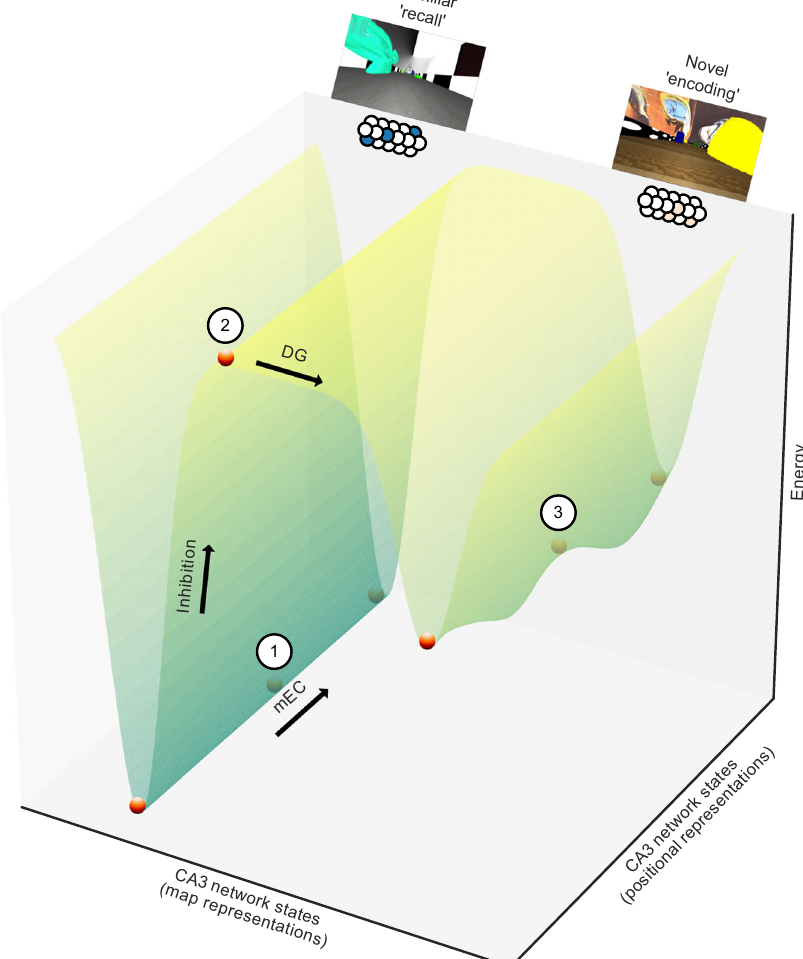
Fig. 6 Switching between familiar and novel attractor states: proposed model. Energy landscape of CA3 network states representing different maps and different positions along the track (schematic). In a familiar environment, the CA3 network falls into an attractor state that is governed by strengthened recurrent synaptic connectivity, thereby performing generalisation during memory recall of familiar events. We propose that a small bias in the inputs from the dentate gyrus (DG) fi rst recruits feed-forward inhibition, thereby lifting the network state out of the deep trough representing the familiar environment. Direct excitation from the dentate gyrus then pushes the CA3 network into a different attractor state with initially weaker, pre-existing recurrent connectivity, thereby performing discrimination during novelty encoding. Numbers represent network states corresponding to the model snapshots shown in Fig. 5c (1: Fig. 5c, left; 2: Fig. 5c, middle; 3: Fig. 5c, right). mEC, medial entorhinal The dura mater was removed using fi ne forceps and the cortical surface was kept monitored daily. Animals were trained to navigate the virtual corridor in the covered with arti fi cial cerebrospinal fl uid of the following composition (in mmol/ familiar environment (F) and to retrieve an 8% sucrose solution reward (10 μ L) by L): 150 NaCl, 2.5 KCl, 10 HEPES, 2 CaCl 2 , 1 MgCl 2 , with pH adjusted to 7.2. In a stopping for at least 3s in an un-cued reward zone placed at a fi xed location of the corridor. Licking behaviour was monitored using a custom-made Arduino piezo- subset of animals, 600 nL of 1mmol/L atropine solution was injected with a large- electric sensor coupled to the reward delivery spout. Animals were ‘ teleported ’ back tip glass micropipette at a depth of 1.7 mm from the cortical surface to selectively to the beginning of the track upon crossing of a de fi ned threshold near the end of target the dentate gyrus 83 . The local injection of the drug was made through a the virtual corridor. As the virtual environments, training protocol and reward standard patch-clamp pipette (thus being equivalent to the fi rst patch-clamp contingencies used in this study are different from the ones used in previous pipette penetration in the ‘ control ’ group) and the anaesthetic and surgical pro- work 12 , the hit rate results are not directly comparable. After having completed the cedures performed on the animals in the ‘ control ’ group and in the group in which fi ve-day training protocol in the familiar environment, a behavioural recording atropine was locally applied prior to recordings were identical. Recording elec- trodes were pulled from fi lamented borosilicate glass (Sutter Instrument) and fi lled session was conducted in which laps in the familiar environment (F) were alter- with internal solution of the following composition (in mmol/L): 135 potassium nated with laps in the novel environment 1 (N1). The same environment alter- methanesulfonate, 7 KCl, 0.3 MgCl 2 , 10 HEPES, 0.1 EGTA, 3.0 Na 2 ATP, 0.3 nation strategy was used during the electrophysiological recordings, using the familiar environment (F) and the novel environment 2 (N2). A purely behavioural NaGTP, 1 sodium phosphocreatine and 5 mg/mL biocytin, with pH adjusted to 7.2 session was conducted separately from the electrophysiological recordings since the with KOH. Osmolarity was 285 – 290 mOsm/L. All chemicals were purchased from latter are typically very short and therefore do not provide enough behavioural data Sigma. Pipette tip resistance was 4 – 8M Ω . Electrodes were arranged to penetrate to accomplish an accurate assessment of task performance. the brain tissue perpendicularly to the cortical surface at the centre of the cra- niotomy and the depth of the recorded cell was estimated from the distance advanced with the micromanipulator (Luigs & Neuman), taking as a reference the point where the recording electrode made contact with the cortical surface. Whole- In vivo whole-cell patch-clamp recordings . Two craniotomies ( ⌀ ~0.5 mm) were cell patch-clamp recordings were obtained using a standard blind-patch approach, drilled 3 – 24 h before the recording session for the recording electrode (right as previously described 12,27,84 . Only recordings with a seal resistance > 1 G Ω were hemisphere, 2.0 mm caudal, and 1.5 mm lateral from Bregma) and the reference included in the analysis. Recordings were obtained in current-clamp mode with no electrode (left hemisphere, 2.0 mm caudal and − 1.5 mm lateral from Bregma).